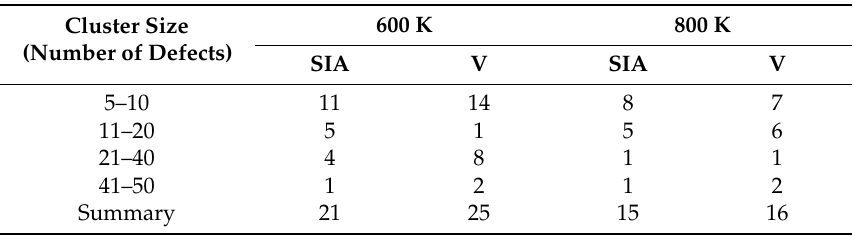
Table 1. Total number of interstitial and vacancy clusters in 20 simulations at 600 K and 800 K. Cluster Size